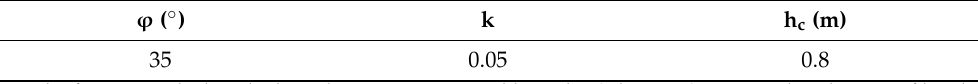
Table 3. Calculated parameters on the landslide.